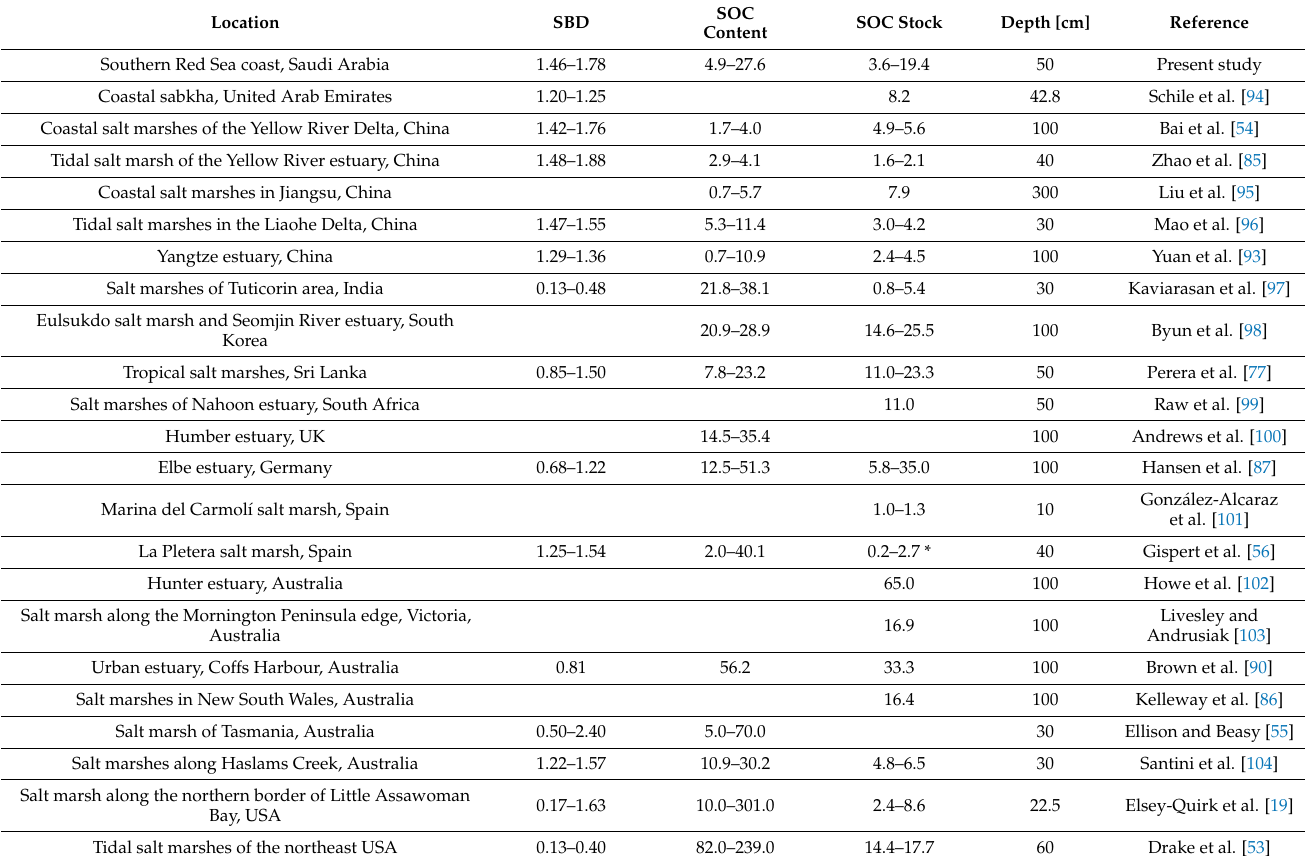
Table 2. Mean of soil bulk density [SBD; g/cm 3 ], soil organic carbon [SOC] content [g C/kg] and SOC stock [kg C/m 2 ] in ten sampling sites represent ten sabkhas with different vegetation covers along the southern Red Sea coast of Saudi Arabia compared with those reported for different salt marshes around the